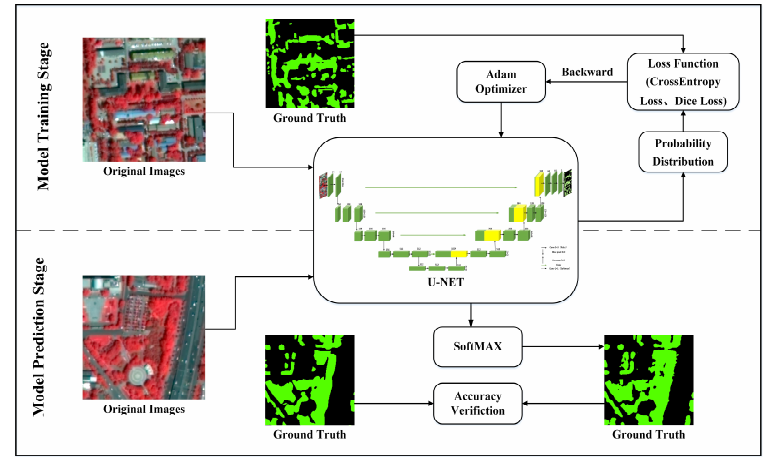
Figure 6. Experimental flowchart of U-NET processing mono-temporal images.